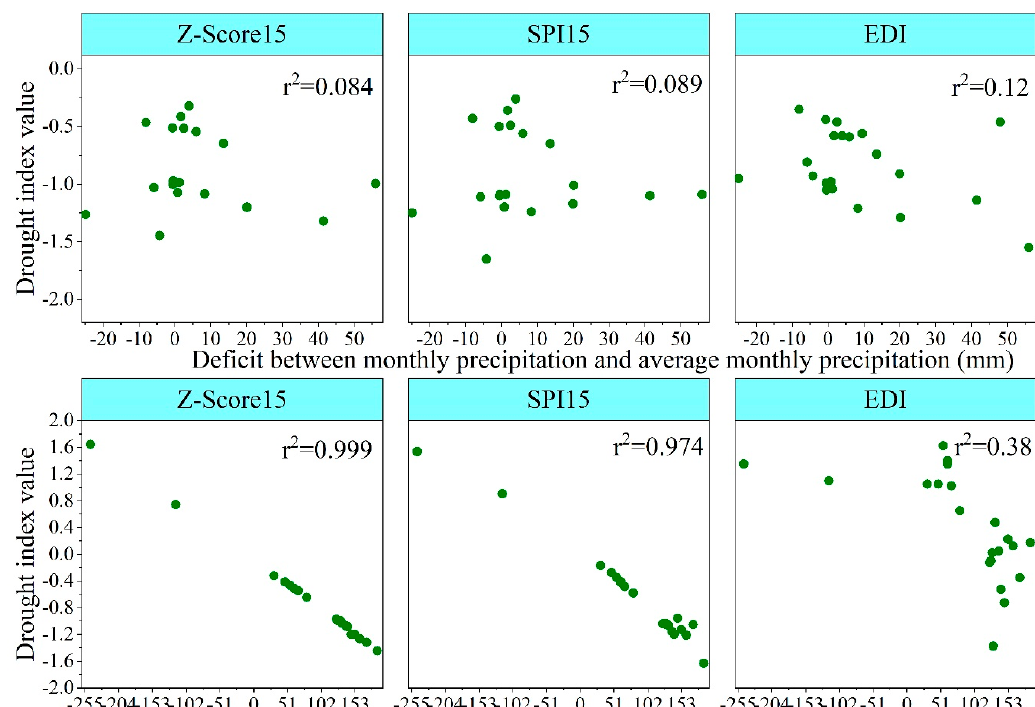
Figure 10. Scatter plots of drought indices (i.e., Z-Score15, SPI15, and EDI) and deficit between monthly precipitation and average monthly precipitation (the first row) and deficit between moving cumulative precipitation and multi-monthly average precipitation (the second row) for the 15-month timestep in Keshan station from September 1999 to May 2001.